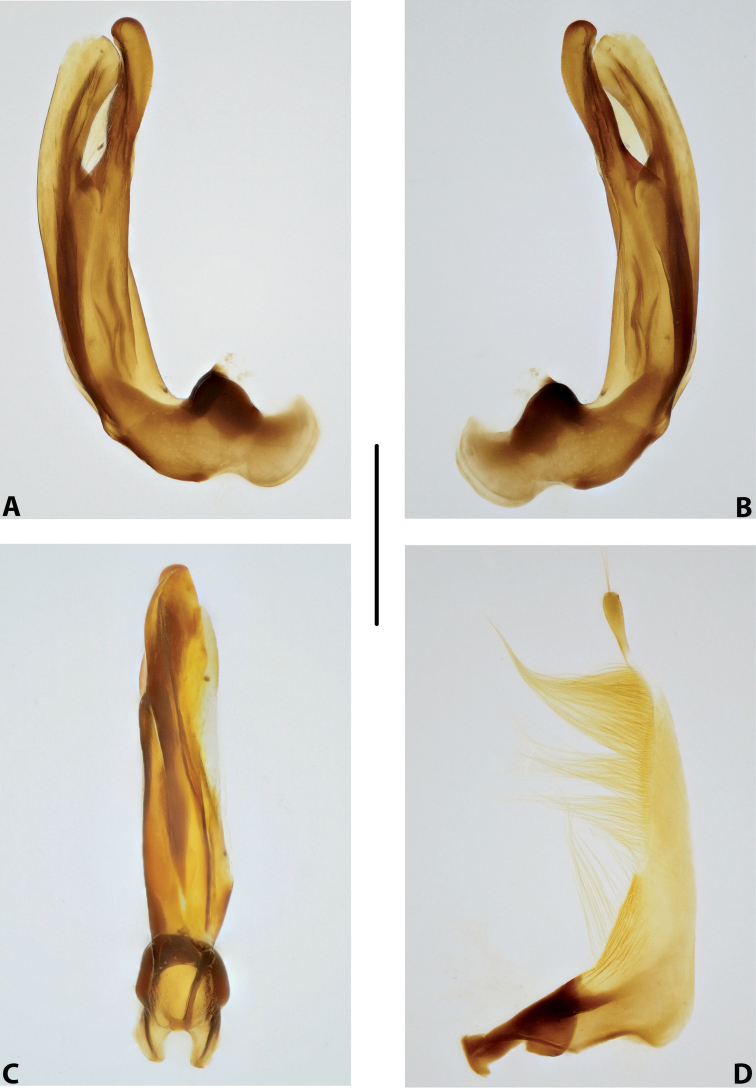
Copelatus
clarkiA median lobe in lateral view, right side B median lobe in lateral view, left side C median lobe in ventral view D left paramere in external view. Scale bar: 0.5 mm.